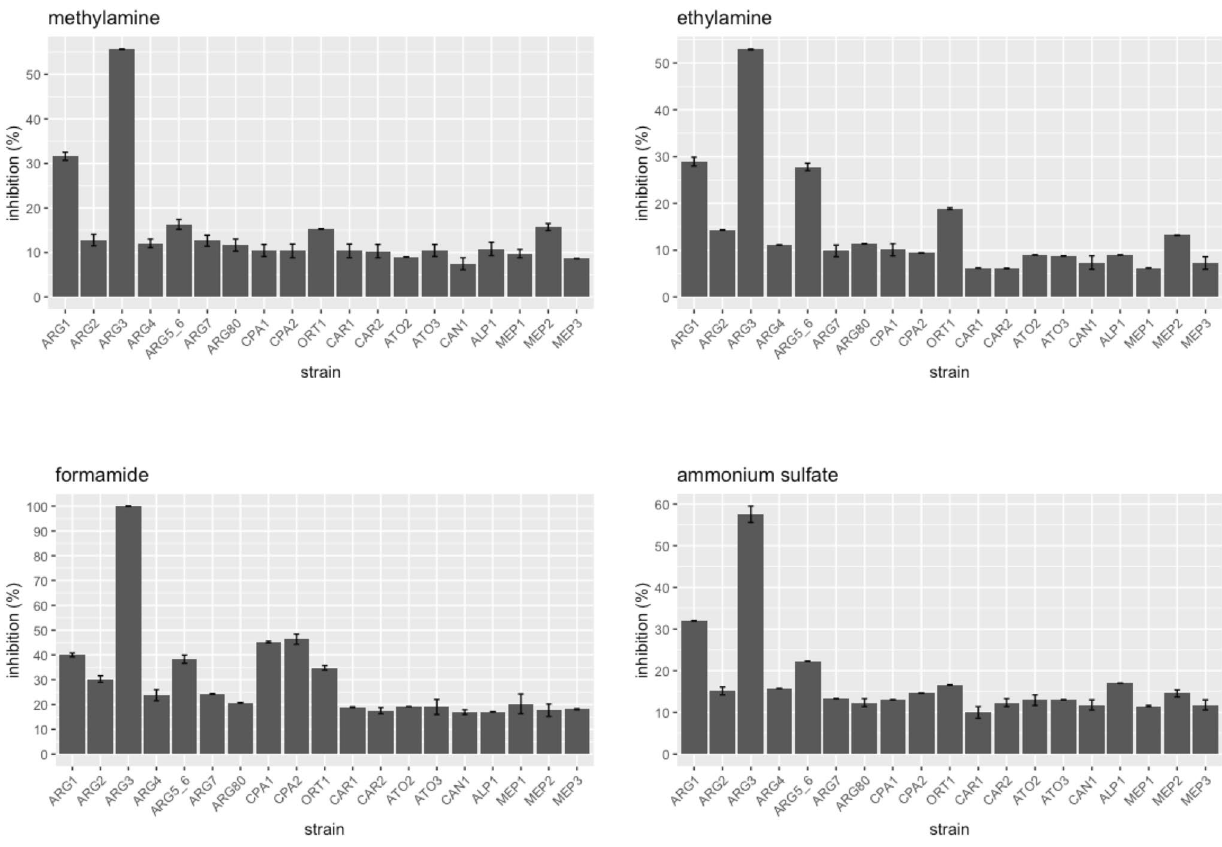
Figure 7. Percent inhibition of the intermediates against nineteen strains lacking arginine and ammonium metabolism genes. Strains lacking CPA1 and CPA2 were sensitive to formamide, but not to methylamine, ethylamine and ammonium sulfate. However, strains that are missing ARG1 , ARG3 and ARG5,6 have increased sensitivity to the four compounds. Each bar represents the mean ± standard of inhibition